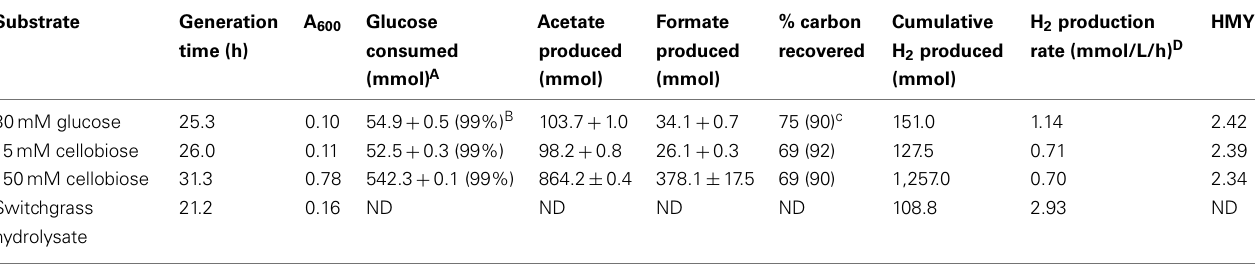
Table 2 | Growth, metabolism and hydrogen production during fed-batch controlled